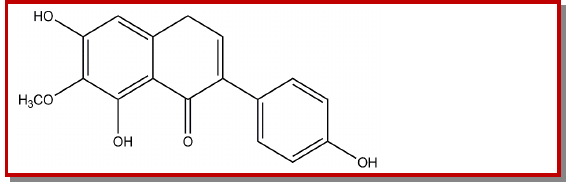
Figure 1: The structure of